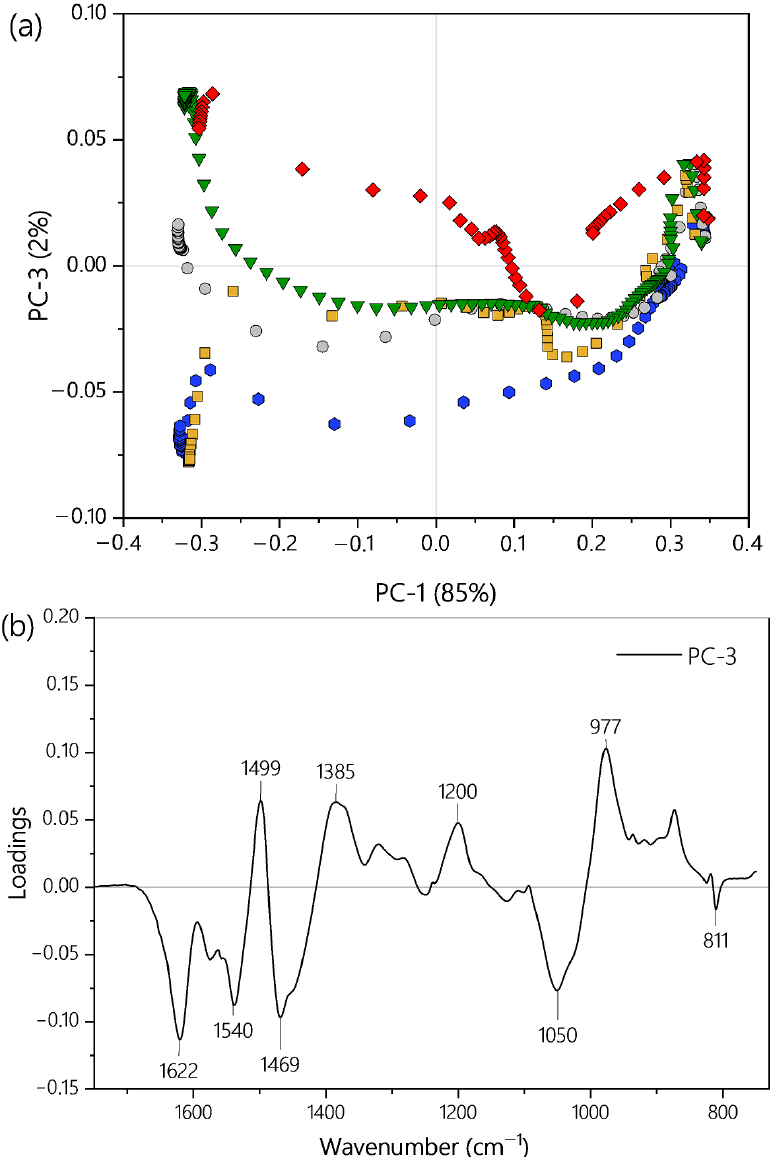
Figure 7. Process trajectories for PCA. ( a ) Score plot (PC1 vs. PC3) of the PCA analysis of the entire synthetic procedure for five of the prepared MF resins. The score plot shows the process trajectories of the factorial experiments (triangular, rhombic, hexagon and square symbols) and center point (circle) settings of the MF resin syntheses. The reaction phase is indicated by blue (phase 1: reactor filling), grey (phase 2: dissolution/methylolation heterogeneous reaction system) and red (phase 3: condensation in homogenous reaction medium) shadows. ( b ) Loadings plots of PC3 of the PCA analysis of the entire synthesis procedure.